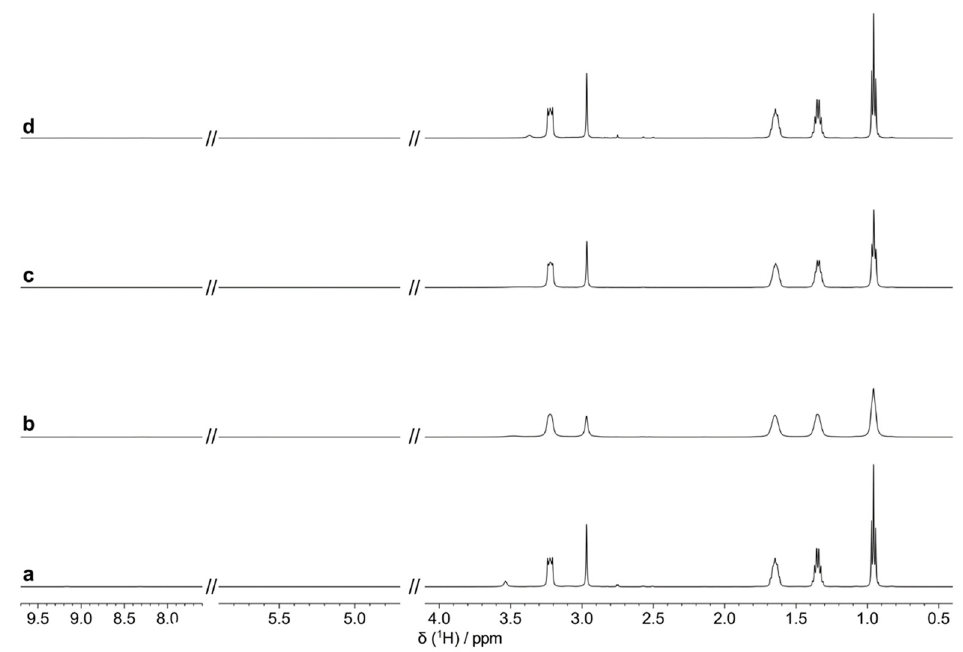
Figure 7. 1 H HRMAS NMR spectra of 4B168 ( a ), 1B168 ( b ), 2B168 ( c ), and 3B168 ( d ).